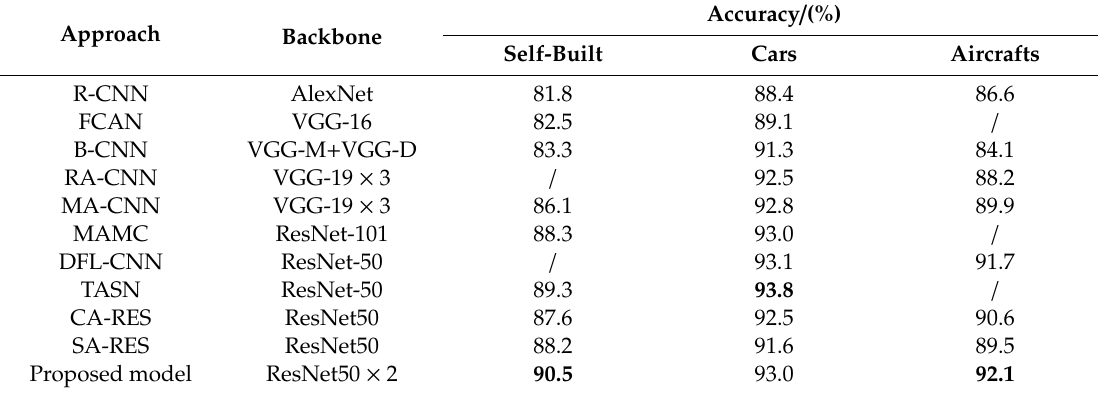
Table 2. Comparative accuracy results of our model with other mainstream weakly supervised methods on di ff erent datasets (our self-built dataset, Stanford Cars, Aircraft).